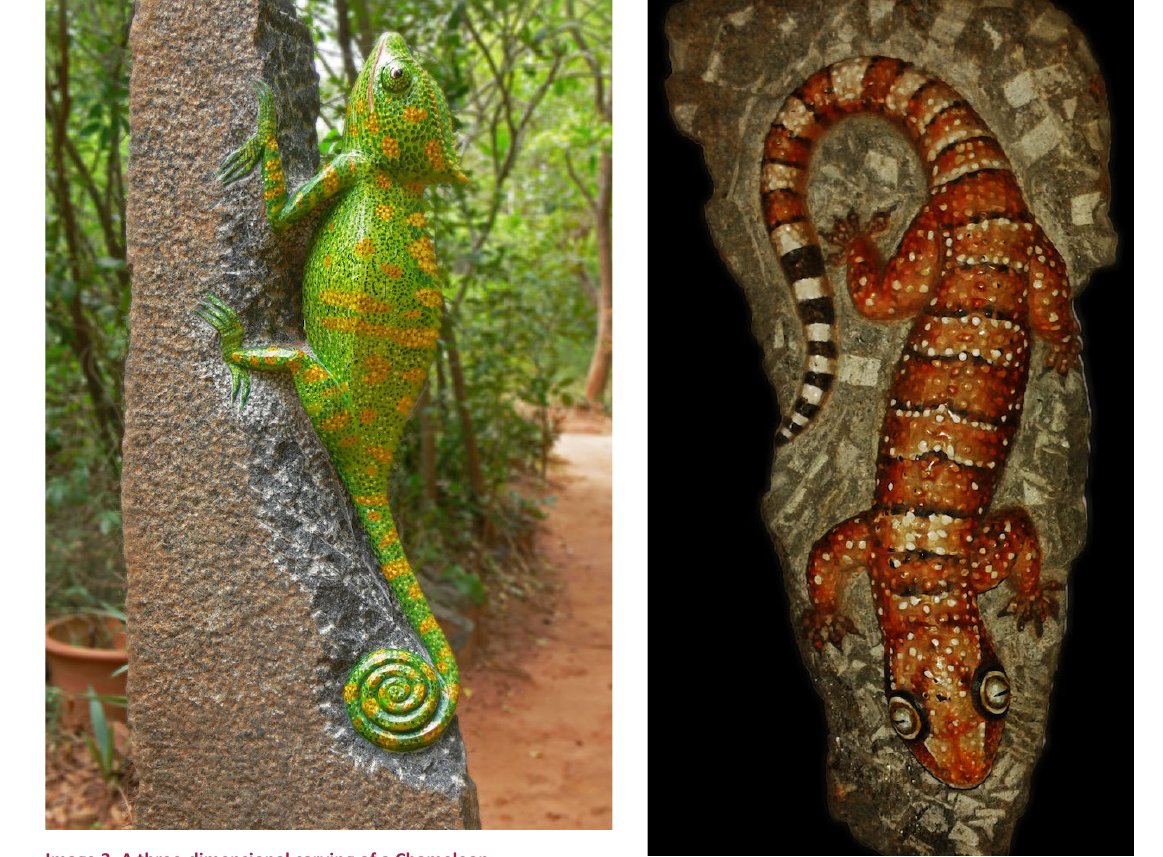
Image 4. An intermediate stage of a carving depicting a Termite Hill Gecko Hemidactylus triedrus . Private collection of Payal Bojwani